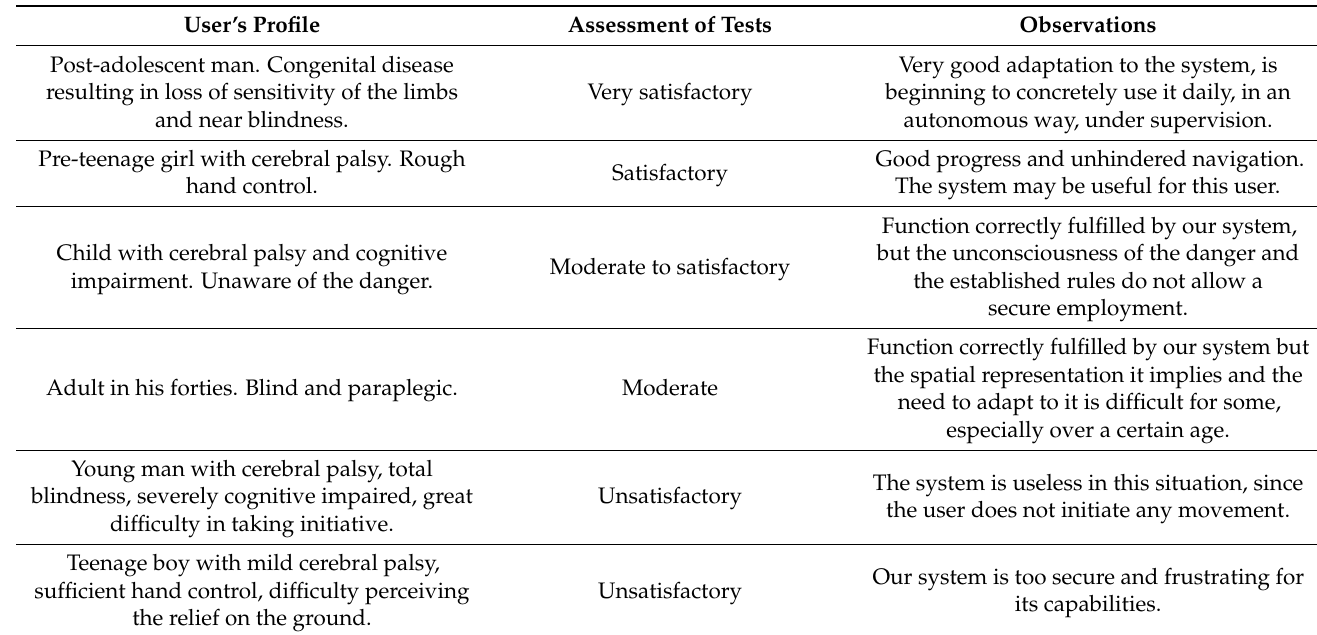
Table 2. User cases studies